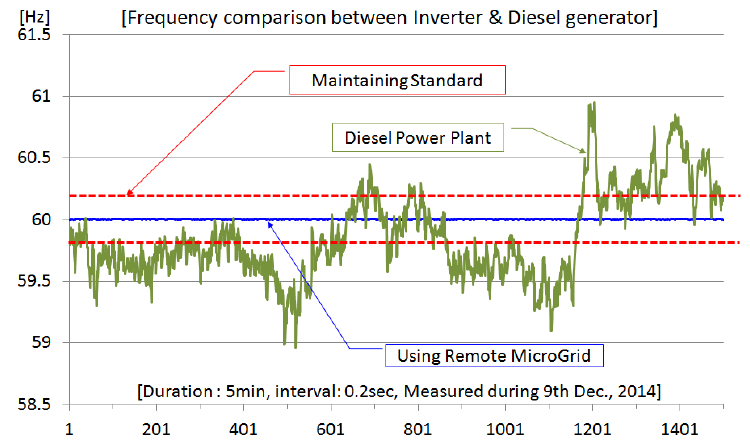
Figure 8. Frequency comparison between the remote microgrid and diesel power plant.